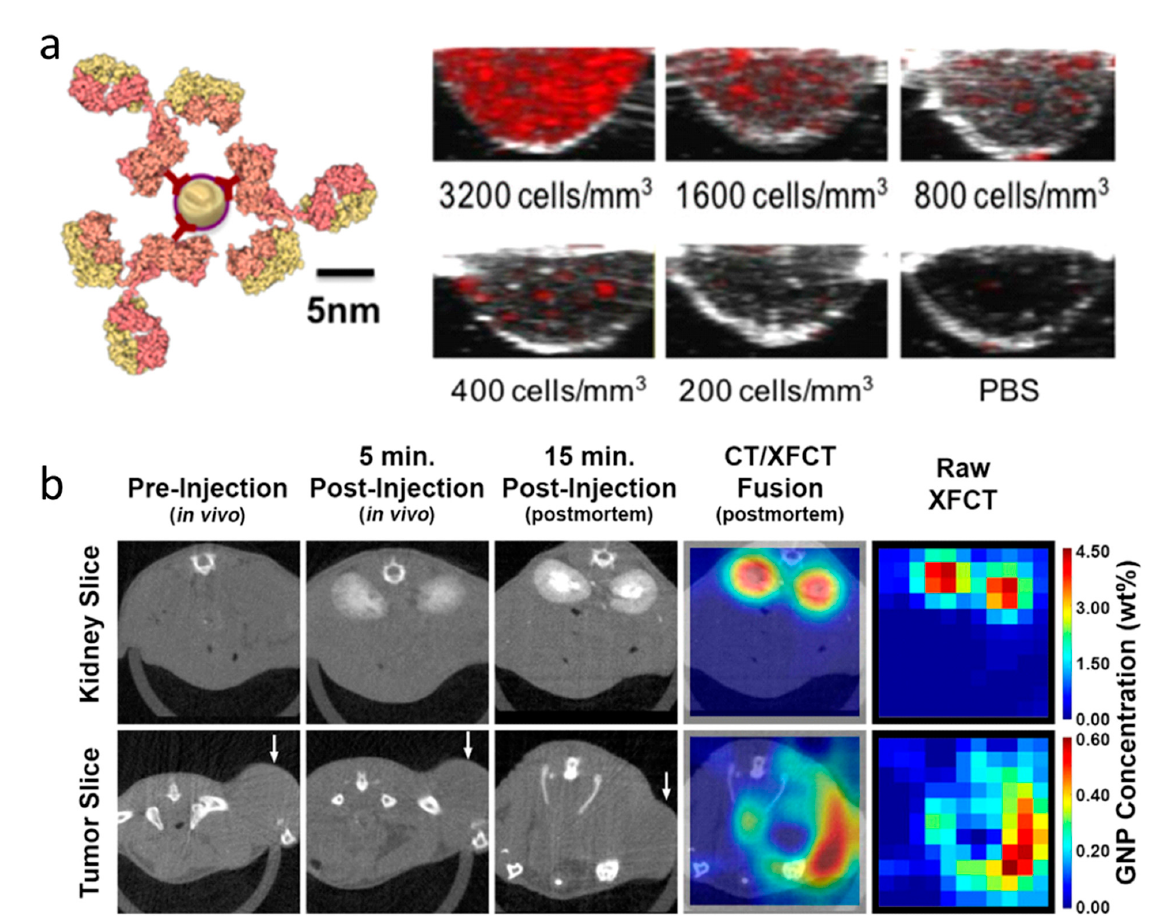
Figure 4. ( a ) Schematic of the epidermal growth factor receptor I (EGFR)-targeted AuNPs and representative Photoacoustic imaging (PAI) cross-sectional images of AuNPs labelled A431 cells at different concentrations. Adapted with permission from [70], copyright 2019 Optical Society of America. ( b ) Time course reconstructed axial CT images after AuNPs injection and X-ray fluorescence computed tomography (XFCT) images at the levels of the kidneys and tumor (white arrow). Adapted with permission from [71], published by Springer Nature.